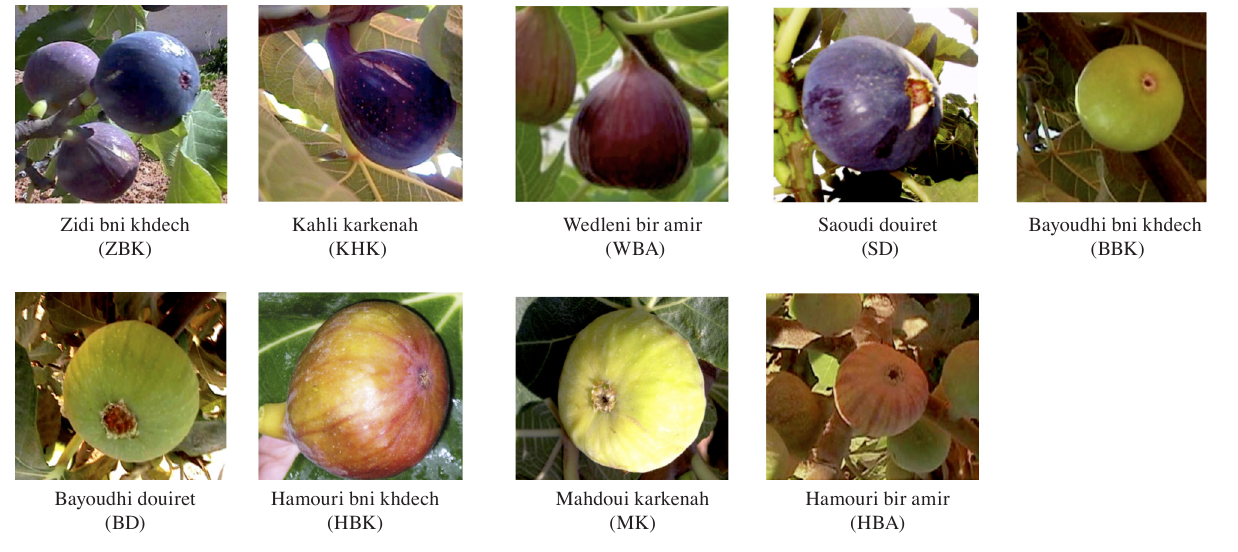
Fig. 1: Nine fig cultivars with different skin colour at ripening stage.